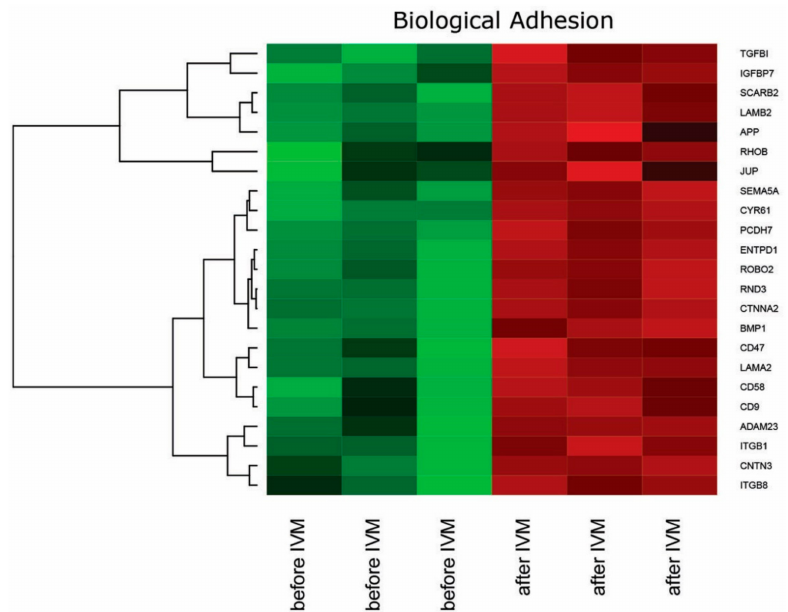
Figure 1. Heat map representation of differentially expressed genes belonging to the “Biological adhesion” functional category from DAVID GEOTERM BP database. Arbitrary signal intensity acquired from microarray analysis is represented by colours (green, higher; red, lower expression). Log 2 signal intensity values for any single gene were resized to Row Z-Score scale (from − 2, the lowest expression to +2, the highest expression for single gene). Table 1. Official genes symbols, fold changes, adjusted p values and ENTREZ Gene ID of differentially expressed genes belonging to the “Biological adhesion” functional category from DAVID GEOTERM BP